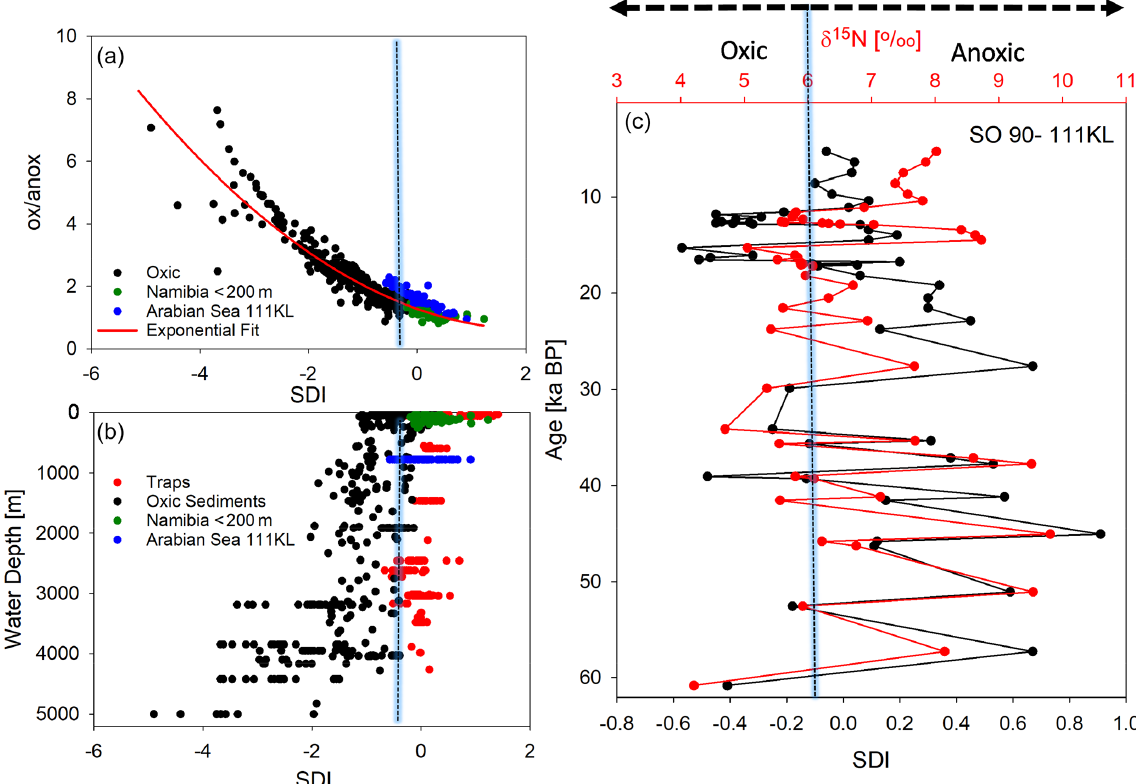
Figure 7. SDI indicator plotted against the ox / anox ratio, with dots indicating oxic sediments (black) and suboxic to anoxic sediments from Namibia (green) and the Arabian Sea (blue). The red line marks the exponential fit to all sediment samples with an R = 0 . 95 (a) . SDI plotted with water depth (in meters) of sediment trap deployment (red) and of sediment sampling (see color code of a ) (b) . SDI and the δ 15 N of total N with sediment depth in sediment core SO90-111 KL correlated with an R = 0 . 71 (c) ; the blue bar marks the threshold of the SDI delimiting oxic and anoxic diagenetic conditions at an SDI value of about −